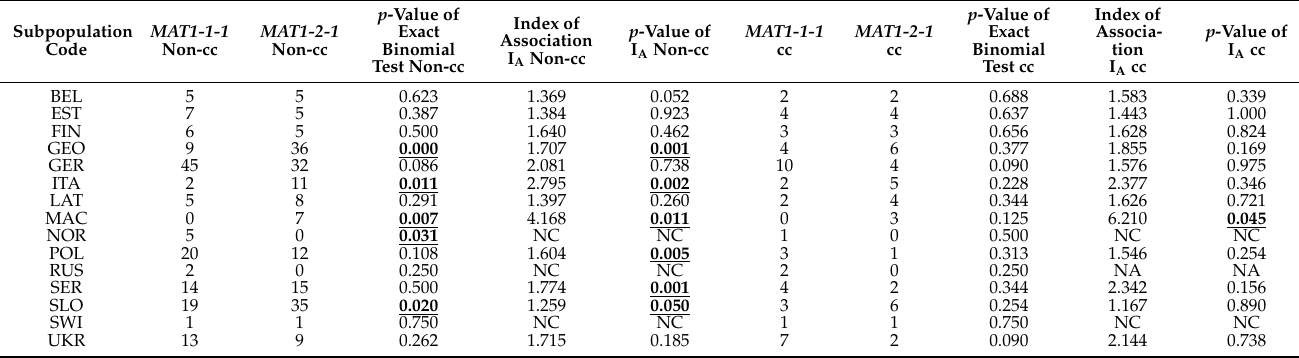
Table 7. Mating type distribution and index of association. Significant p -values are highlighted in bold and underlined. Subpopulation